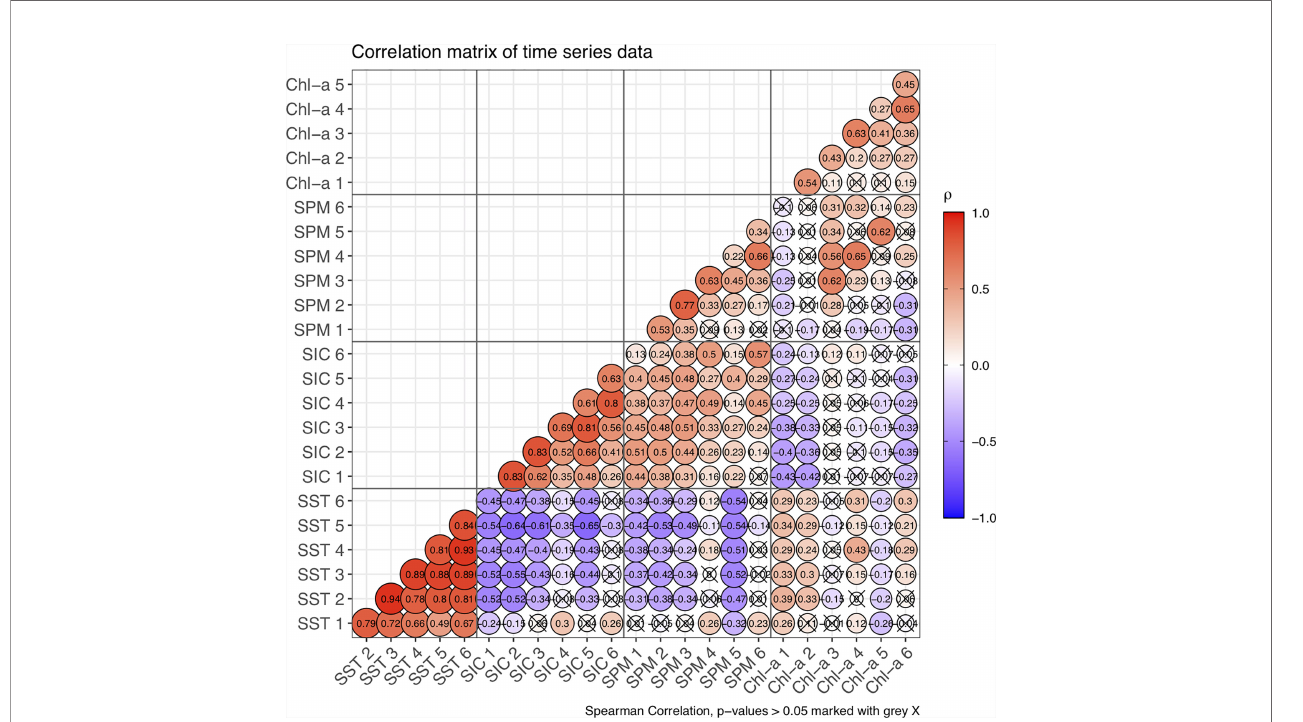
FIGURE 7 | Correlation matrix of time series between parameters, with parameter and region number indicated (i.e., SST 1 is SST of Region 1). The size of the bubble indicates the signi fi cance (low p-value corresponds to large bubble; p-value > 0.05 covered by a grey “ X ” ) and colour indicates the Spearman correlation coef fi cient ( r